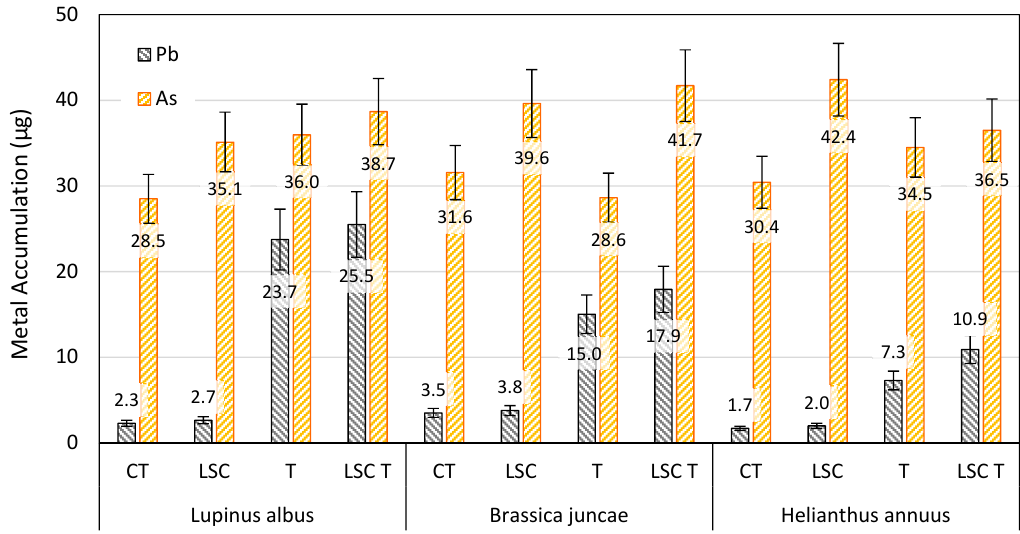
Figure 11. Total accumulation ( µ g) of Pb and As in the aerial part of the plants. Values are reported as mean ± standard deviation.